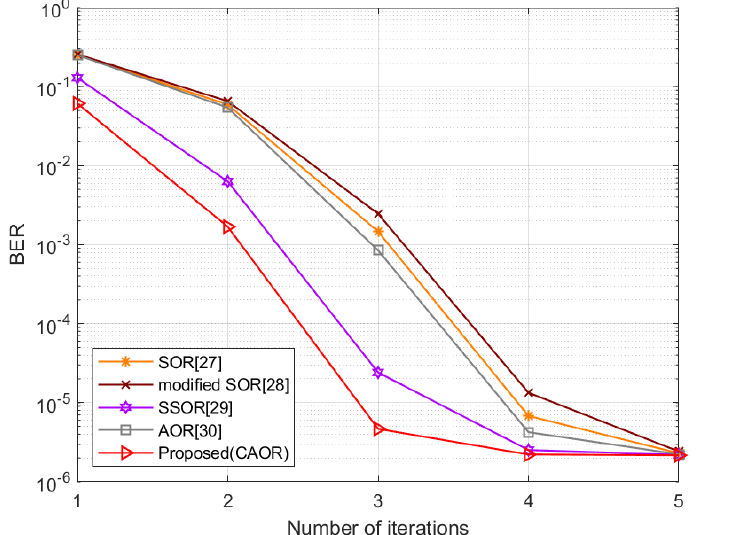
Figure 9. BER performance vs. number of iterations with N R × N T = 128 × 16 and SNR = 45